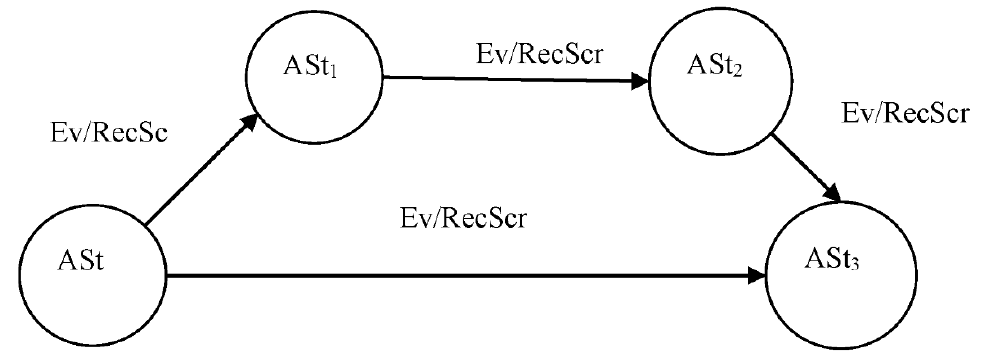
Figure 4. High level automaton model.